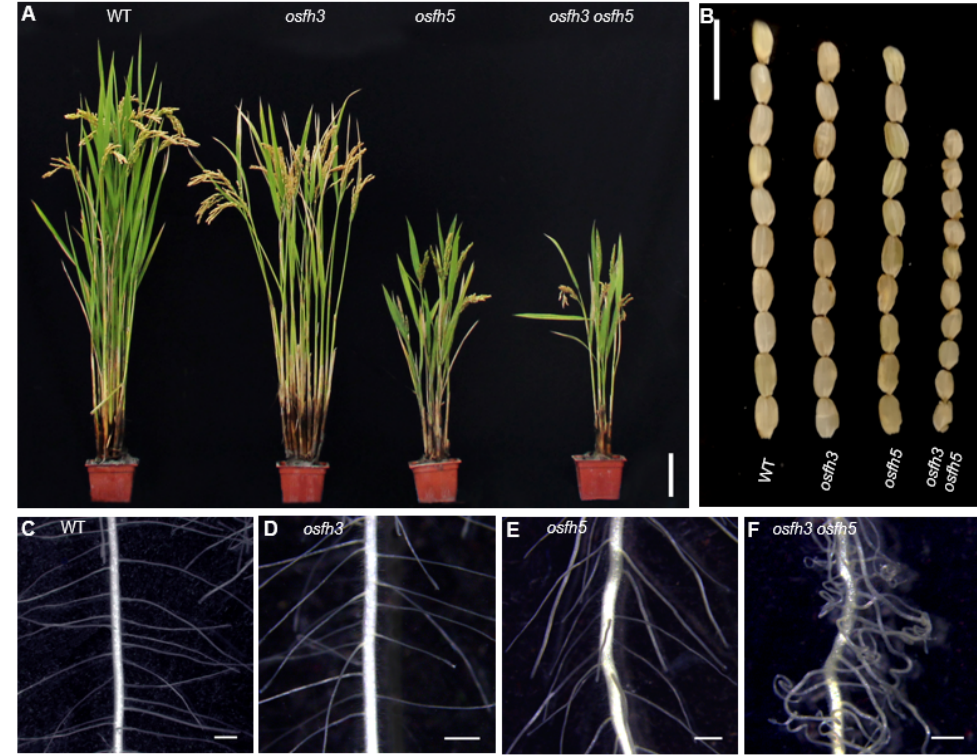
Figure 1. Phenotypes of WT, osfh3 , and osfh5 single and double mutant plants. ( A ) Plant height at grain maturation. Bar = 10 cm. ( B ) Mature grains. Bar = 1 cm. ( C – F ) Lateral roots of 3-day old seedlings. Bar = 1 mm.